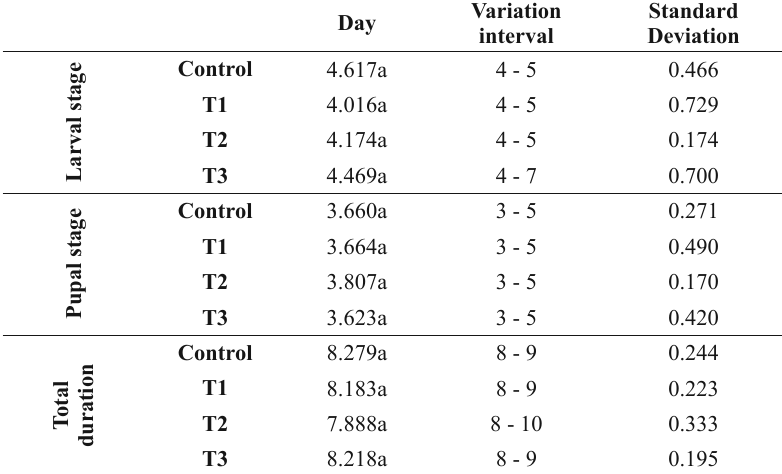
(Table III). The pupal viability of T1 (lower than in the other treatments) differed signi fi cantly from the control and T2, and the pupal viability of T3 differed from the